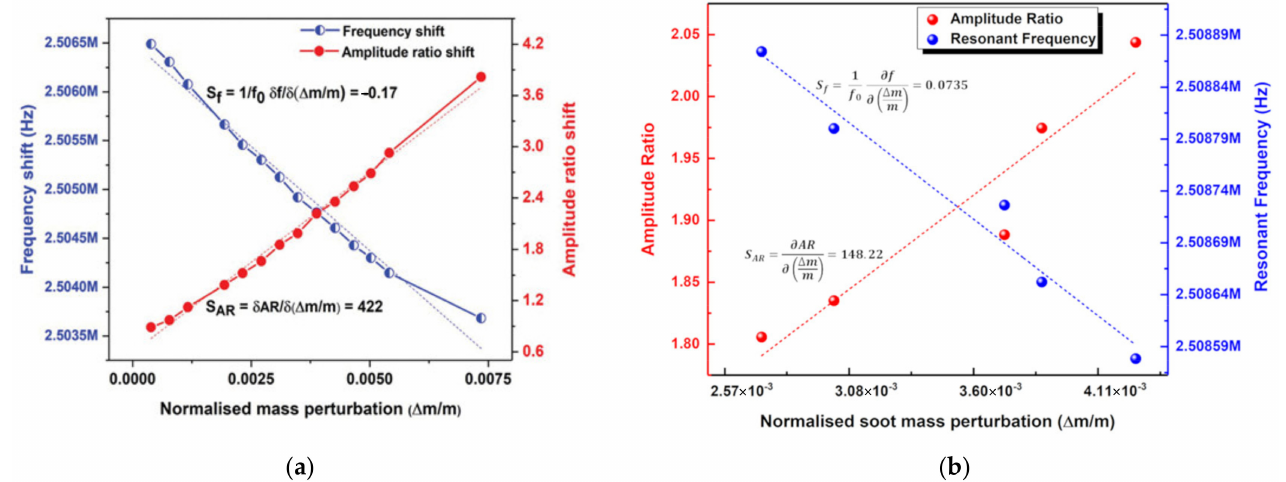
Figure 28. ( a ) Normalized sensitivity based on frequency shift and amplitude ratio shift (Reprinted with permission from Ref. [41]); ( b ) Normalized sensitivity based on frequency shift and amplitude ratio shift from (Reprinted with permission from Ref.